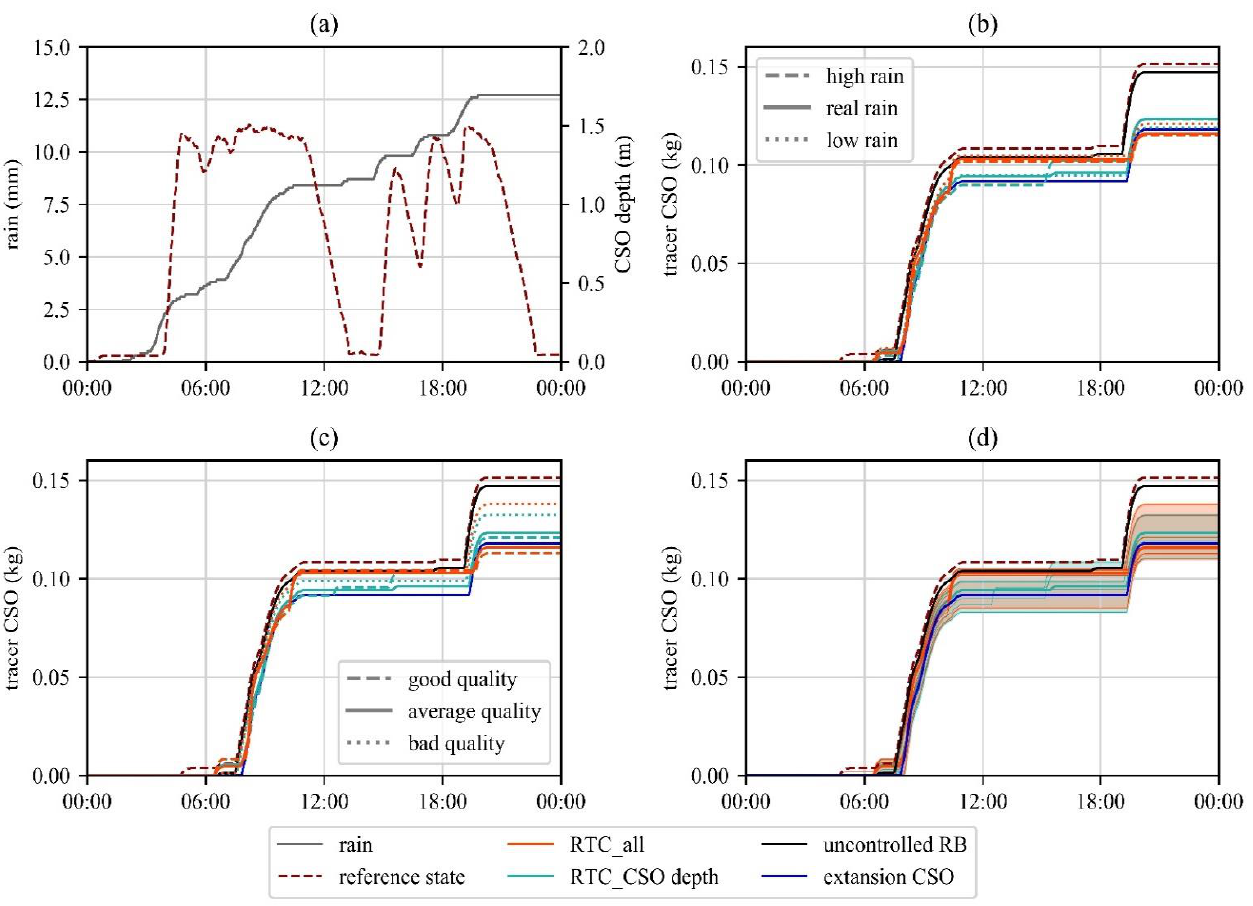
Figure 3. Performance evaluation for a real rain event on 29 March 2018 subdivided into the control strategies ‘RTC all’ and ‘RTC CSO depth’ compared with the reference state without any RBs and uncontrolled RBs; ( a ) temporal pattern of precipitation and CSO depth for the reference state; ( b ) effects of uncertainties in weather forecasts with the scenario ‘average quality’ of data communication on tracer load in CSO; ( c ) effects of uncertainties at data communication with the scenario ‘rail rain’ on tracer load in CSO; and ( d ) illustration of all investigated scenarios highlighting the range of uncertainties associated with smart RWH systems.